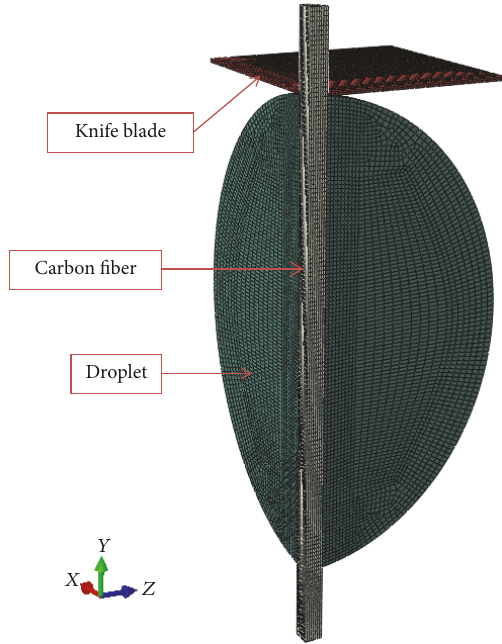
Figure 5: Quarter symmetric FEM of the microdroplet test.